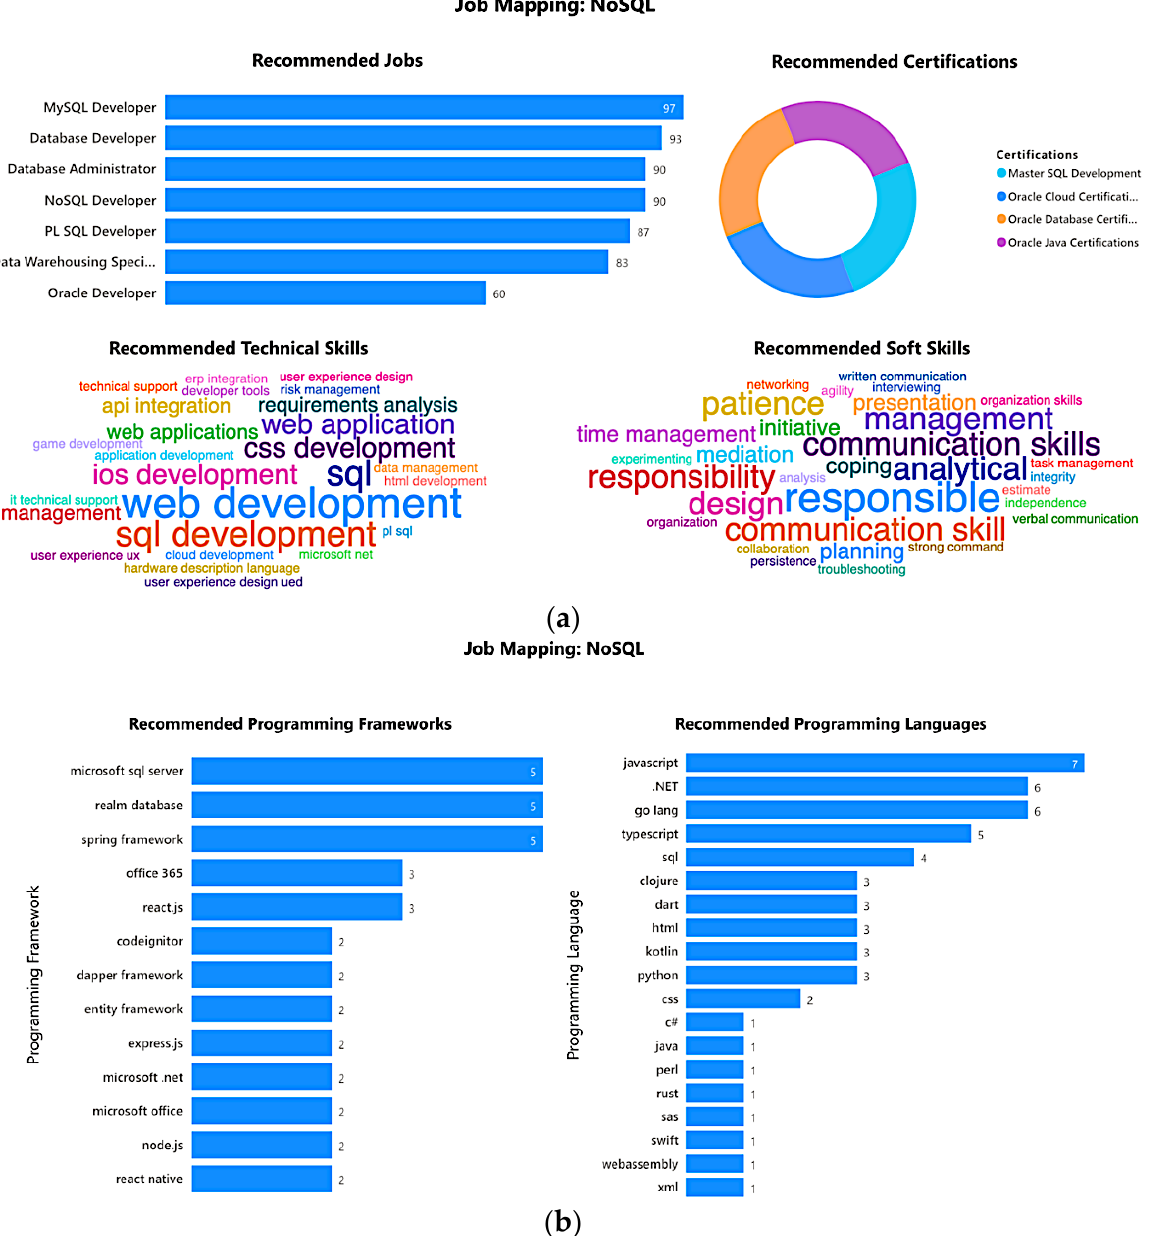
Figure 5. ( a ) Recommended jobs, certifications, and technical and soft skills for NoSQL. ( b ) Recommended programming frameworks and languages for NoSQL.